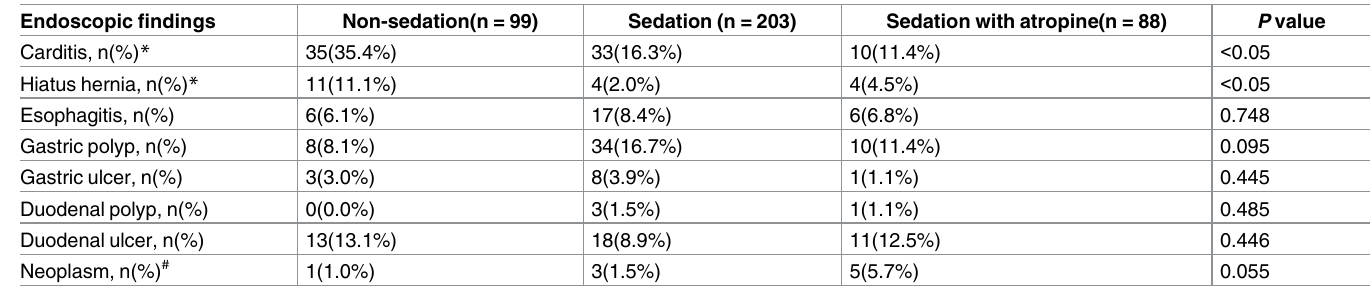
Table 2. Endoscopic findings during